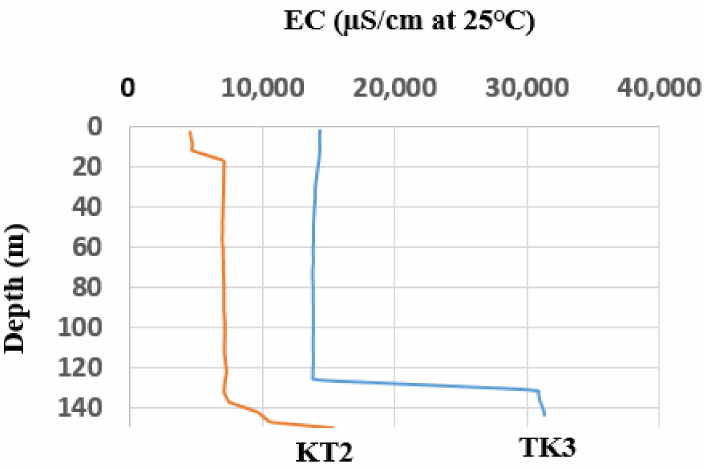
Figure 10. Vertical EC logging values within wells KT2 and TK3 on 19 July 2021.